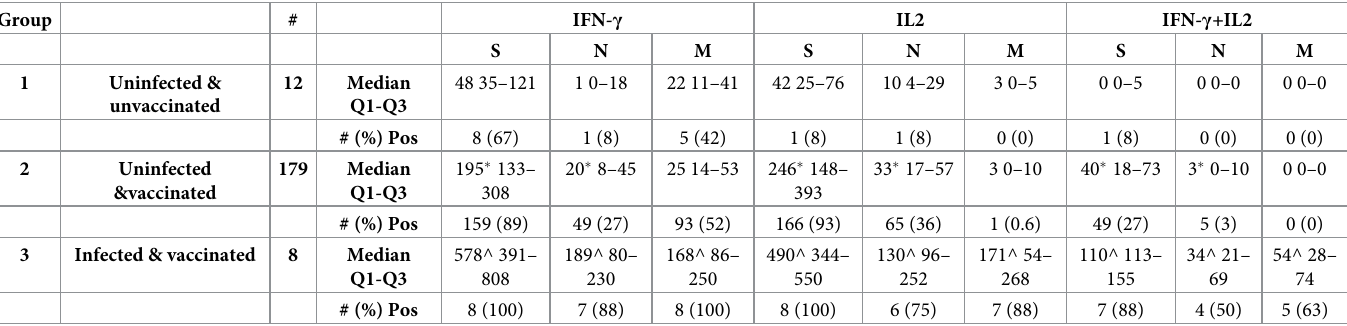
Table 1. Summed FluoroSpot IFN- γ , IL2, and IFN- γ +IL2 responses to S, N and M proteins.